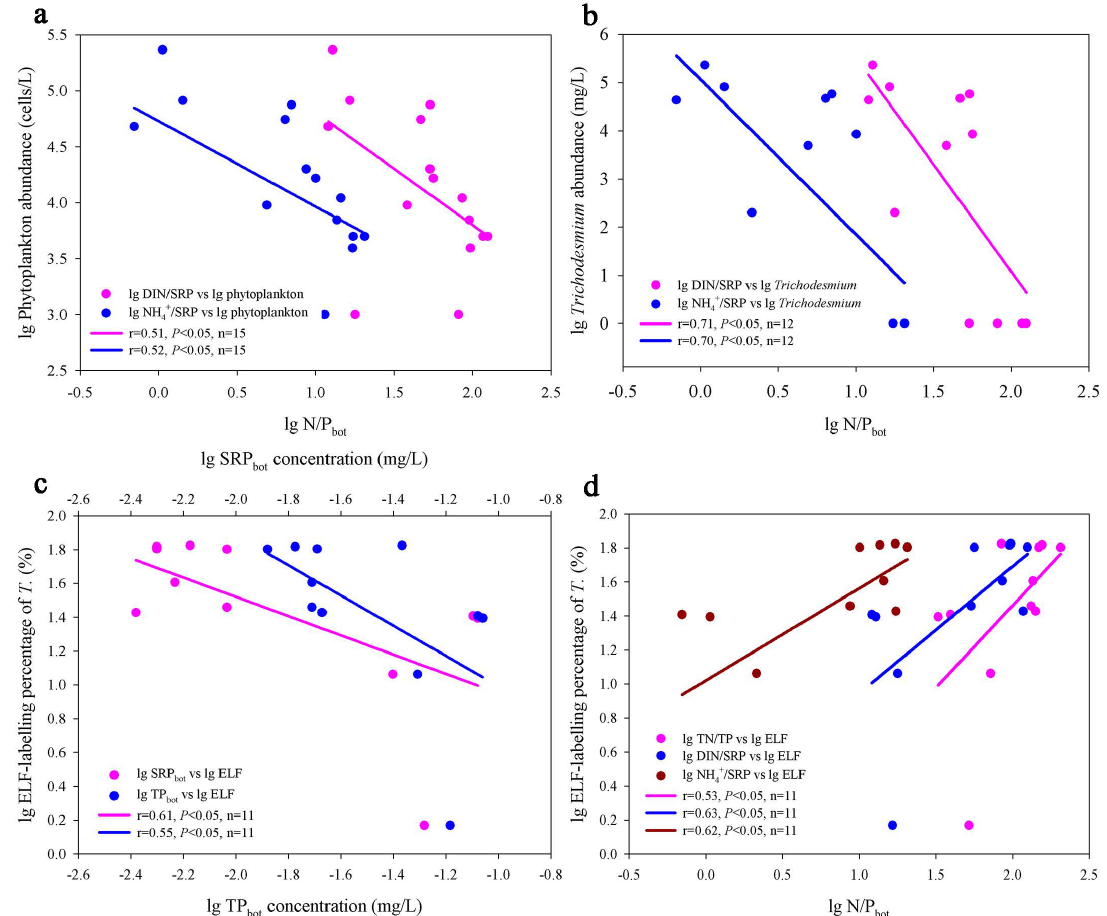
Figure 5. Correlations between phytoplankton abundance in surface water and inorganic N / P ratio in bottom water ( a ), the abundance of Trichodesmium in surface water and inorganic N / P ratio in bottom water ( b ), percentage of ELF-labeling cells in Trichodesmium and total phosphorus (TP), SRP concentrations in bottom water ( c ) and percentage of ELF-labeling cells in Trichodesmium and N / P ratio in bottom water ( d